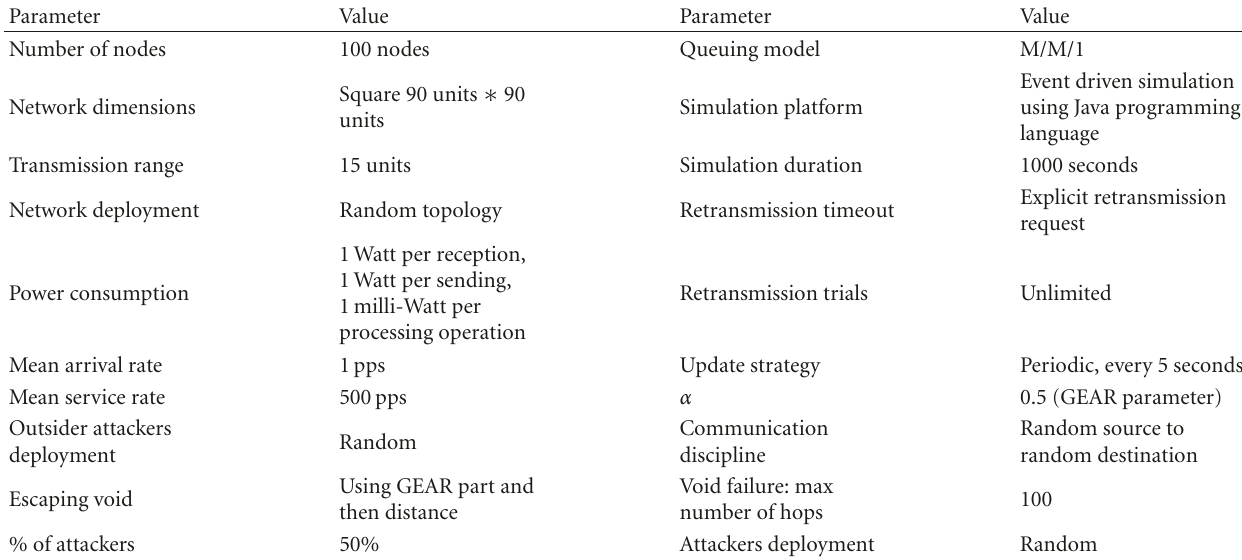
Table 2: Simulation parameters for repuation system experemints.